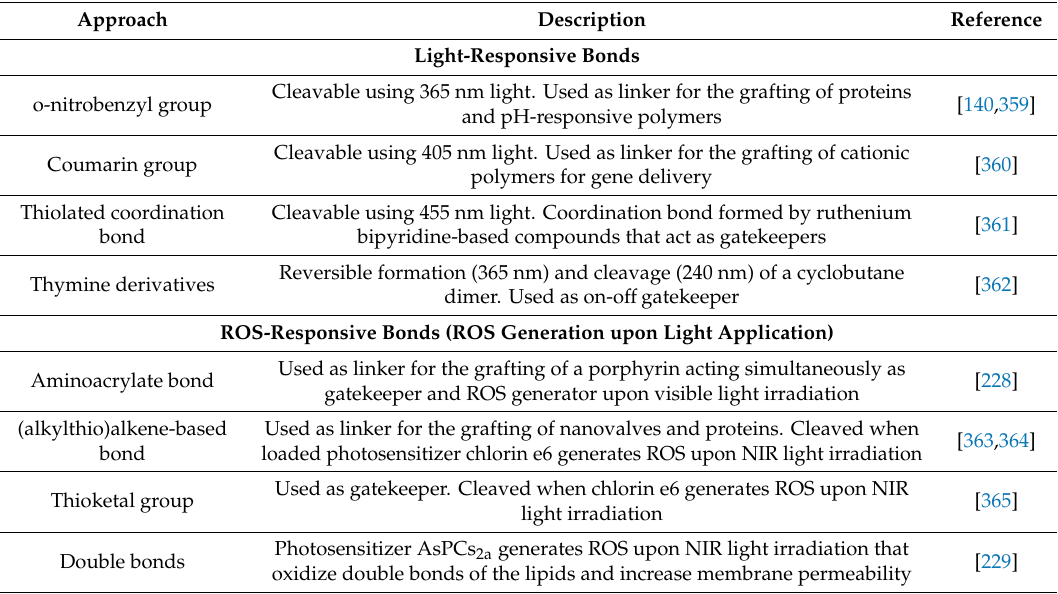
Table 5. Di ff erent strategies implemented into MSNs for achieving light-responsive drug